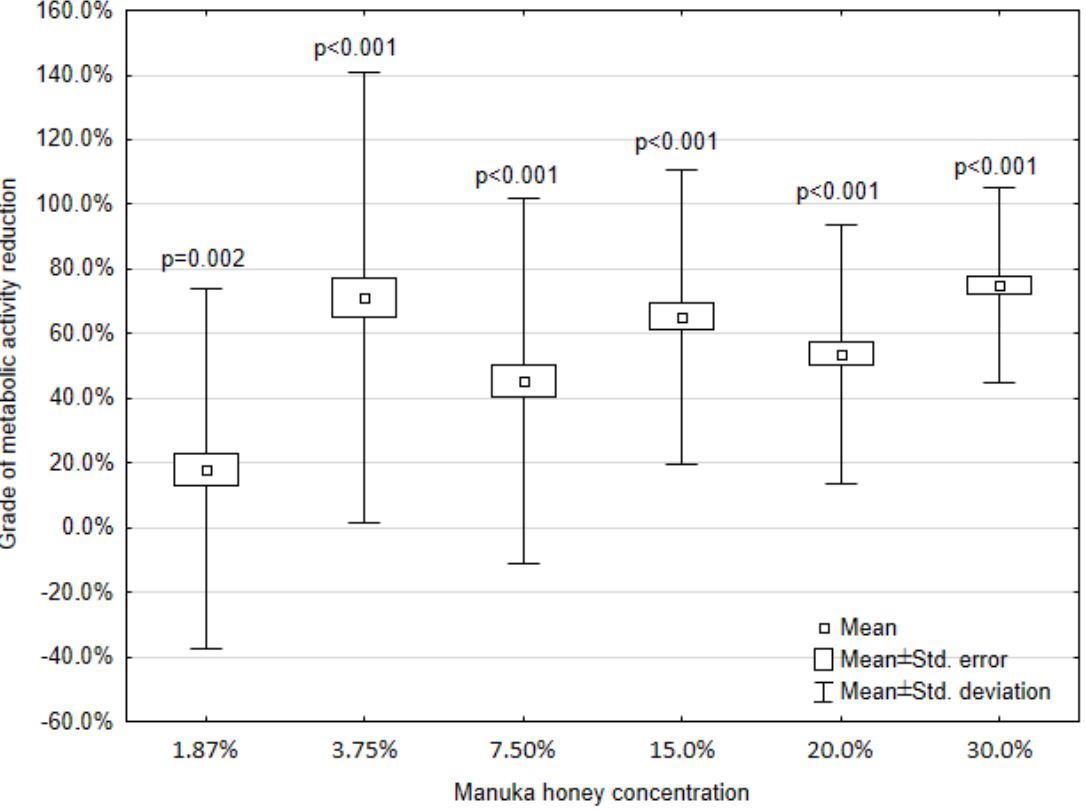
Figure 1. Impact of Manuka honey on the metabolic activity of P. mirabilis biofilm; p -values refer to the comparison between MH concentration and the positive control.